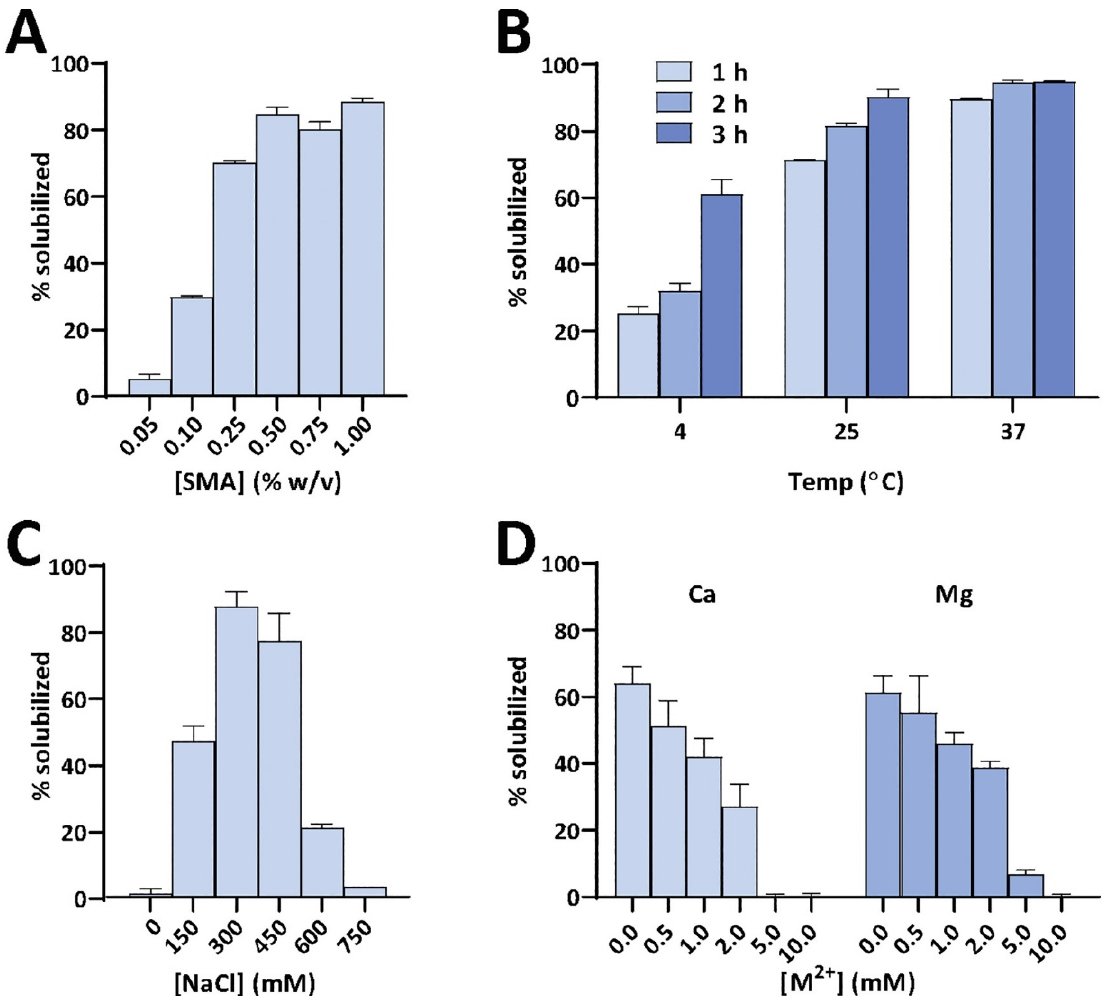
Figure 3. Influence of various environmental parameters on SMA-based solubilization of E. coli membranes expressing KcsA in 10 mM Tris buffer at pH 8. Other parameters were varied, as indicated in the figure, with standard conditions being: 0.25% ( w / v ) SMA, 2 h incubation at 25 °C in 300 mM NaCl, and 15 mM KCl. ( A ) Influence of SMA concentration. The amount of membrane material was kept constant, and SMA was added at different final concentrations in the range of 0.05–1% ( w / v ). ( B ) Influence of incubation time and temperature. ( C ) Influence of salt concentration. Different amounts of NaCl were added at a constant ratio of NaCl/KCl of 20. The sample devoid of NaCl contained 5 mM KCl to ensure the structural stability of the KcsA tetramer. ( D ) Influence of divalent cations (M 2+ ). CaCl 2 or MgCl 2 was used at a concentration of 0–10 mM; all samples contained 15 mM KCl in Tris-HCl 50 mM, pH 8. Data are averages of 2 independent samples, with the error margin indicating the difference in solubilization between both samples. Overall, increasing SMA concentration, temperature (~25 to 37 °C), incubation time, and salt concentration (~300 to 450 mM) are shown to enhance the solubilization yield of KcsA. pH is also shown strongly influence efficiency of SMA, with maximum efficiency reached for pH 8 or 8.5. This Figure and caption are adapted with permission from reference [111] . As both the SMA-based polymer (carboxylate groups) and resin (Ni 2+ -NTA) are charged molecules, they interact and affect the binding of a His-tagged protein to